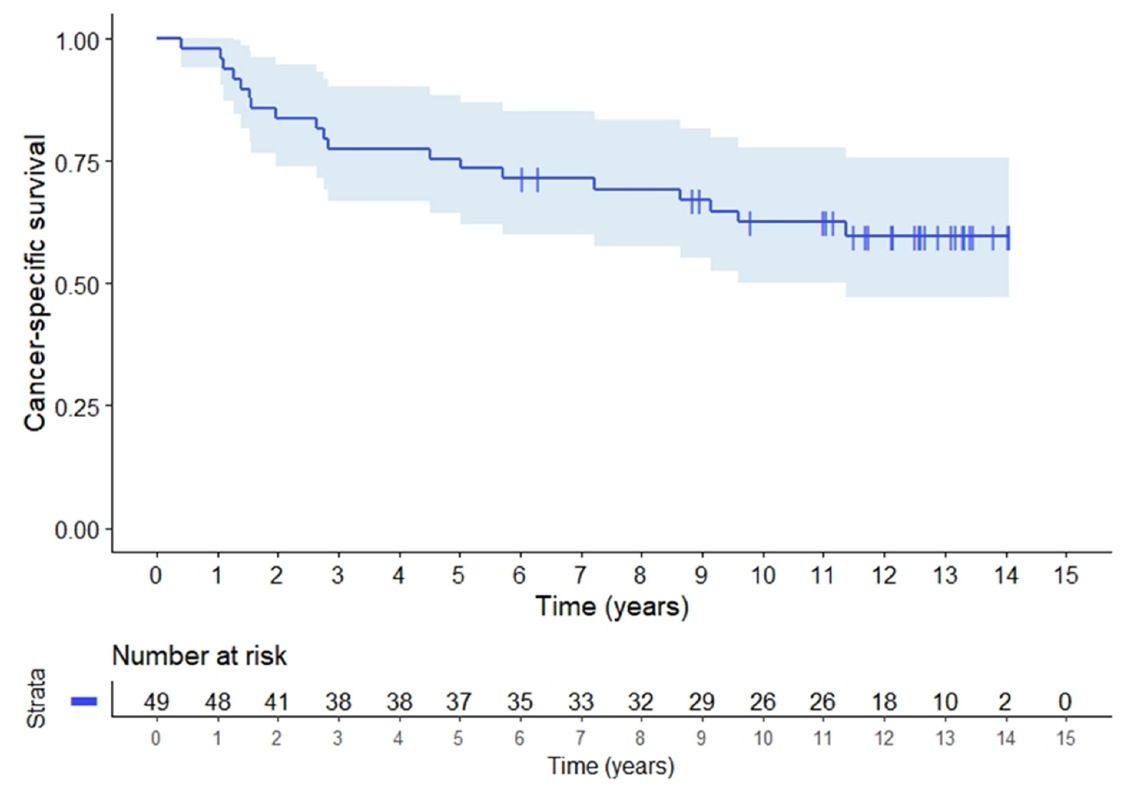
Figure 3. Cancer specific survival (CSS) for 49 patients, 43 with locally advanced and 6 patients with local recurrences of rectal adenocarcinomas.